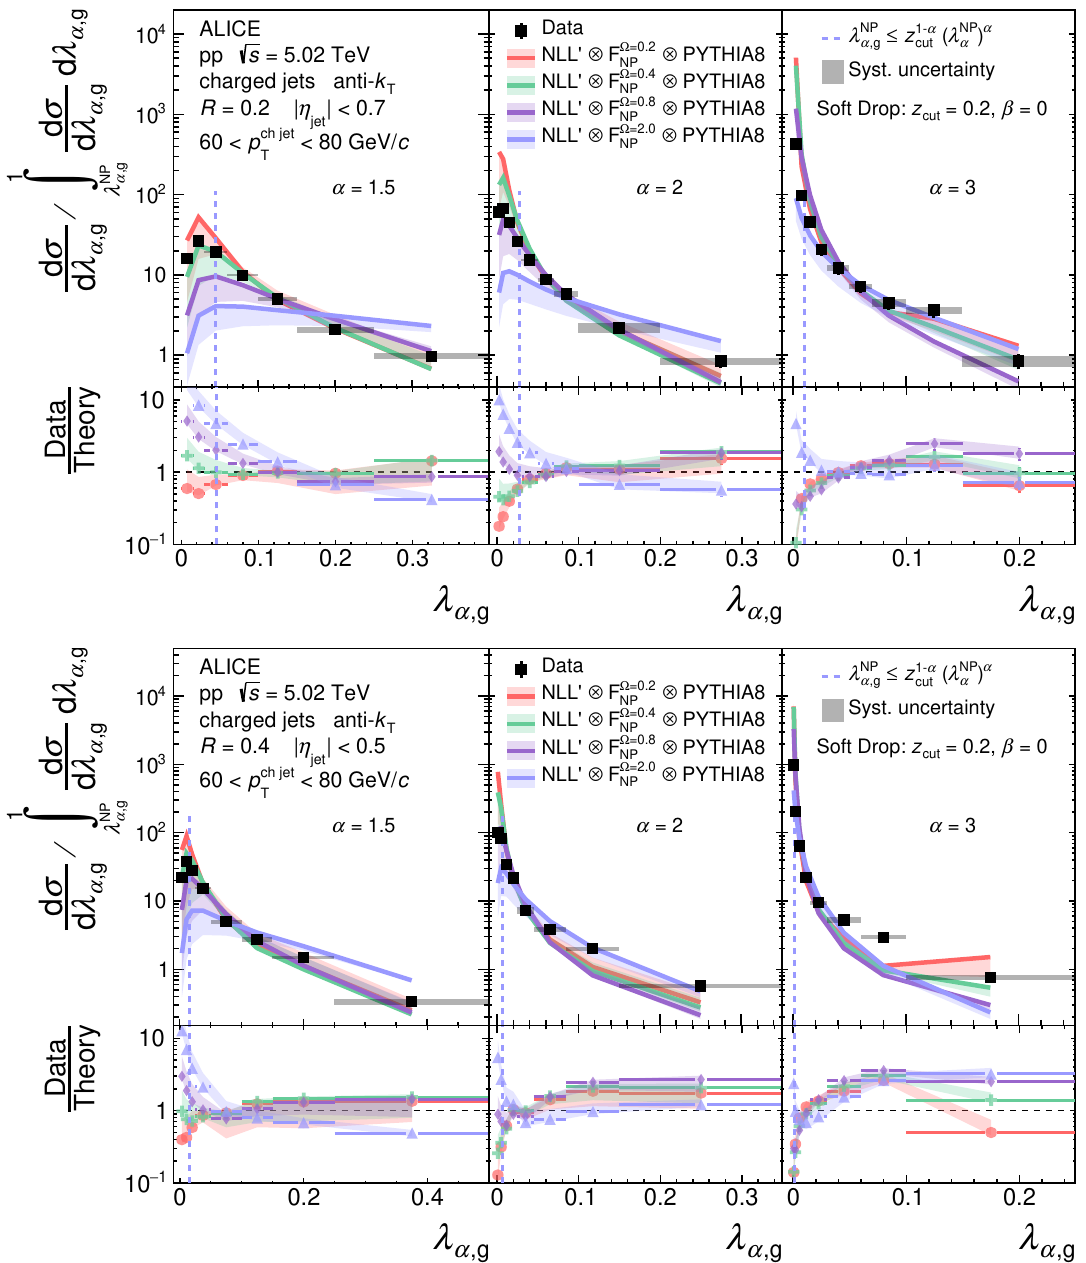
Figure 8 . Comparison of groomed jet angularities λ α, g in pp collisions for R = 0 . 2 (top) and R = 0 . 4 (bottom) to analytical NLL 0 predictions using F ( k ) convolution in the range 60 < p ch jet GeV /c . The distributions are normalized such that the integral of the perturbative region defined by λ α, g > λ NP (to the right of the dashed vertical line) is unity. Divided bins are placed into the α, g left (NP)